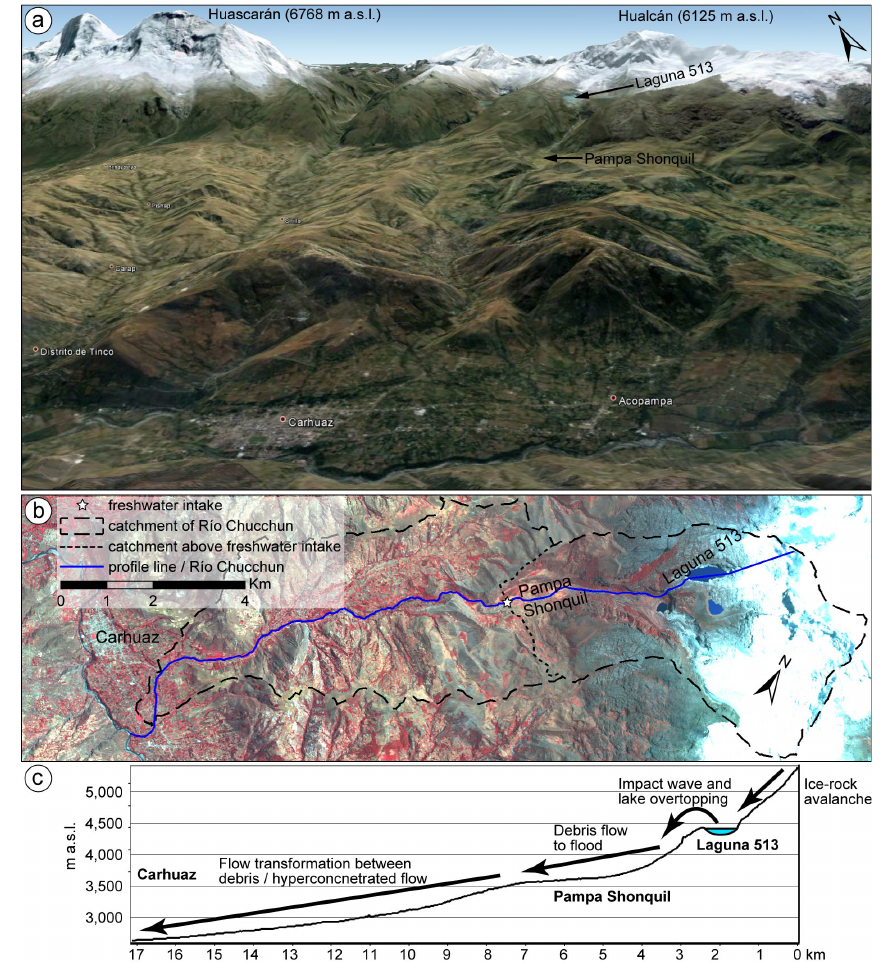
Fig. 2. Overview of the Río Chucchun catchment above the City of Carhuaz. (a) 3-D view from Google Earth, (b) SPOT satellite image from 2006 with the flow path (blue line) of the cascading mass movement processes and (c) the corresponding elevation